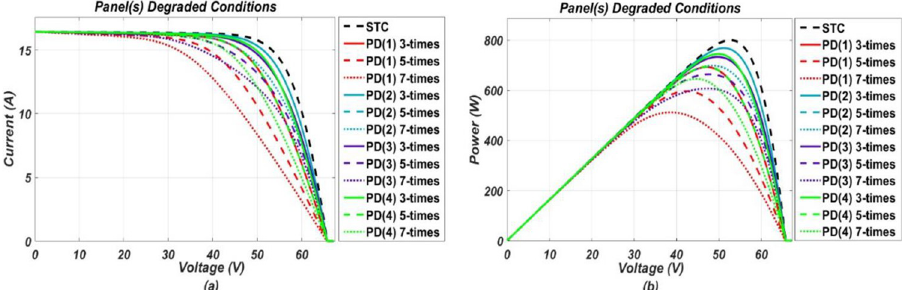
Fig 5. (a) and (b), I-V and P-V graphs respectively, representing response of the P.V. system under panel(s) degradation conditions of different intensity levels.